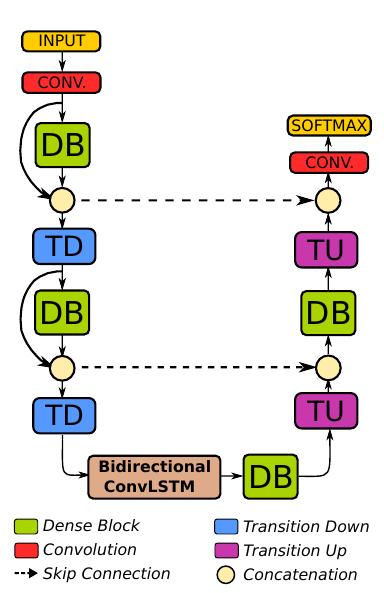
Figure 5. Class distribution in (a) Campo Verde and (b) LEM datasets.